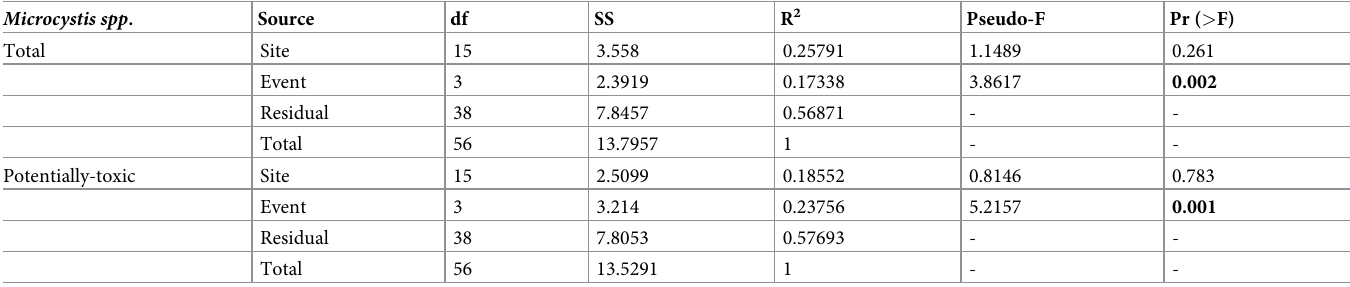
Table 4. PERMANOVA tests for total and potentially-toxic Microcystis (cell equivalents g -1 ) between sites (1.1–15.1) and event (November 2014, April 2015, November 2015, and April 2016). Tests were based on the non-Euclidean Bray-Curtis dissimilarity measure and were done using 999 permutations under the reduced model. Bold values indicate significant differences at p < 0.05. Microcystis spp